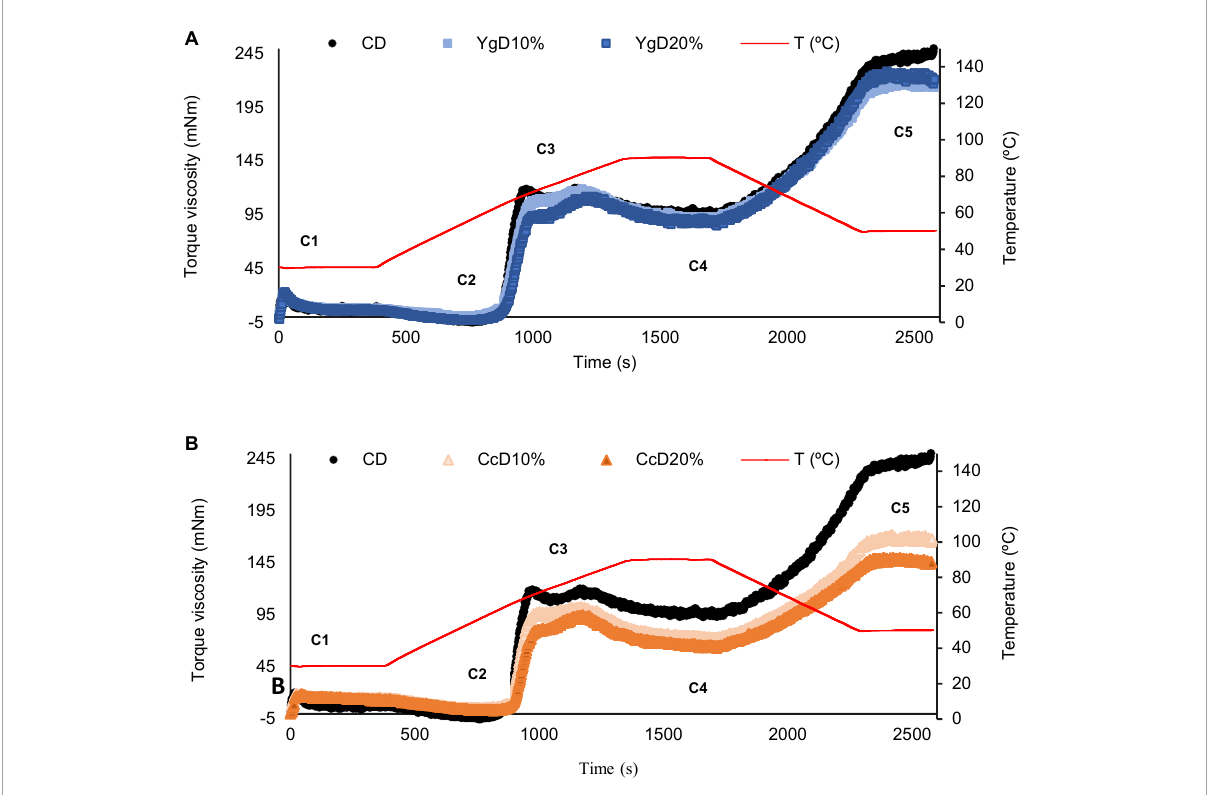
FIGURE1 Comparison of pasting properties profile of dairy gluten-free dough, obtained by different levels (10–20%, w/w) of yoghurt (A) and curd cheese (B) addition, with control bread dough profile (black line).